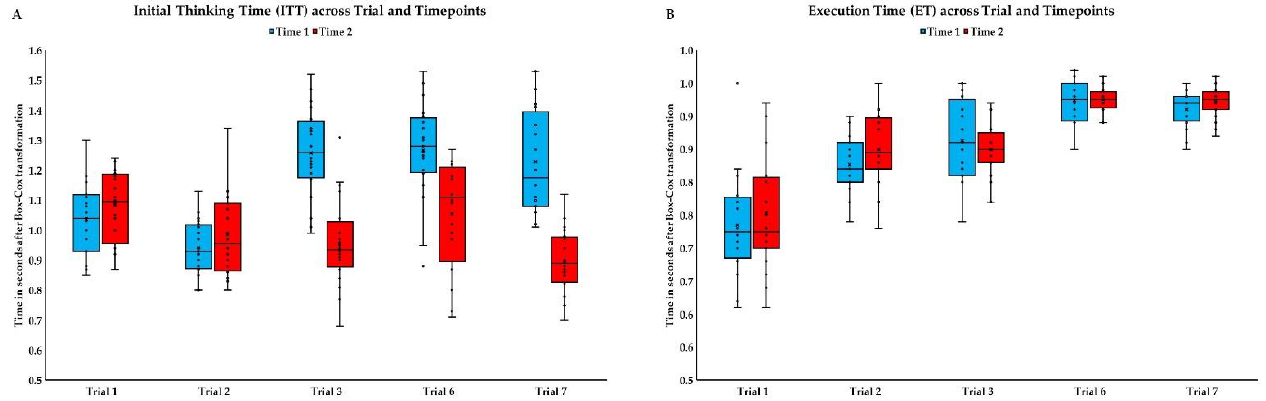
Figure 3. Performance in Tower of London (TOL) task, across repeated measurements: ( A ) Initial Thinking Time and ( B ) Execution Time (blue boxes, Time point 1; red boxes, Time point 2). In all box plots, the bottom end of the box designates the first quartile, a line within the box indicates the median, and the top end of the box shows the third quartile. Whiskers indicate values 1.5 times the interquartile range below the first quartile and above the third quartile. Crosses represent average values. Circles designate individual observations.